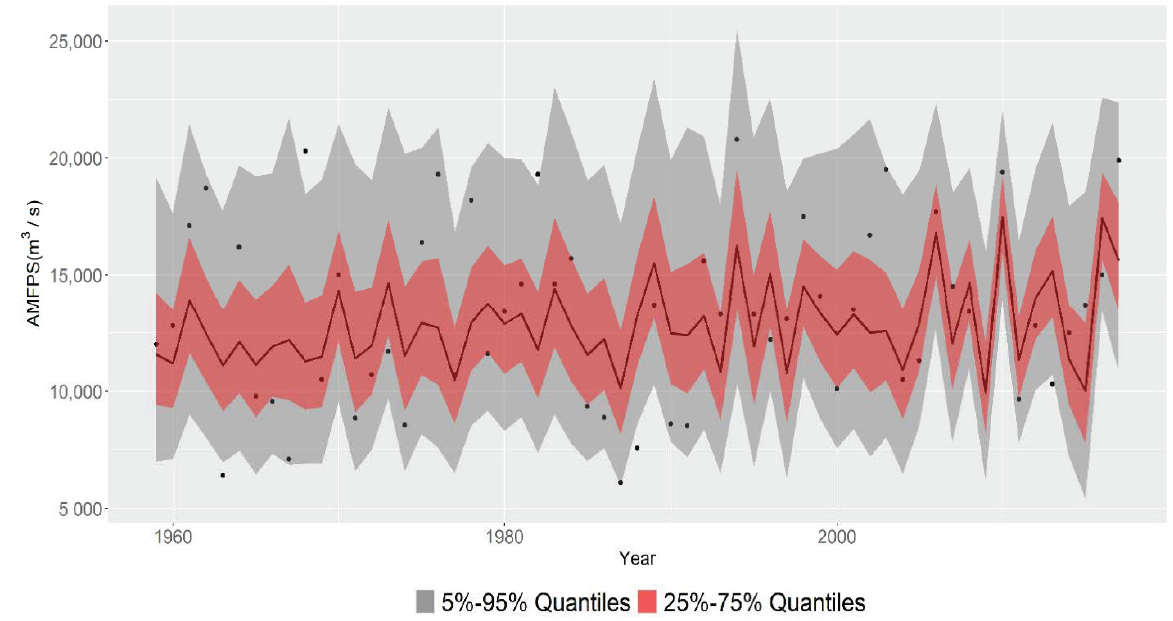
Figure 7. The centiles curve plots of the optimal model LN C -3.